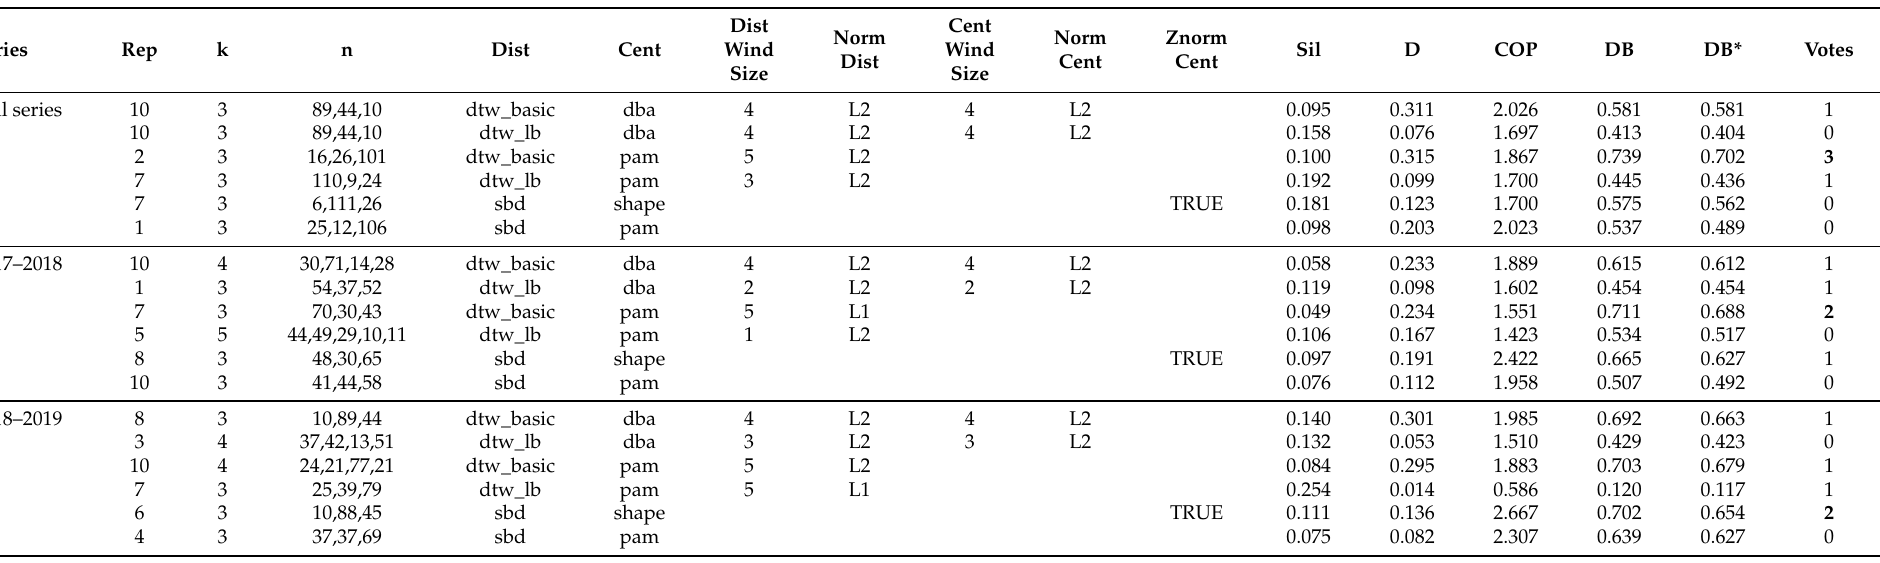
Table 2. Results of the best clustering configurations per type of algorithm. References: rep, repetition, k, number of clusters, n, number of time series in each cluster, DTW, Dynamic Time Warping; PAM, Partition Around Medoids; SBD, shape based distance, Sil, Silhouette; DB, Davies–Bouldin; DB*, Modified Davies–Bouldin; D, Dunn; COP, COP index.